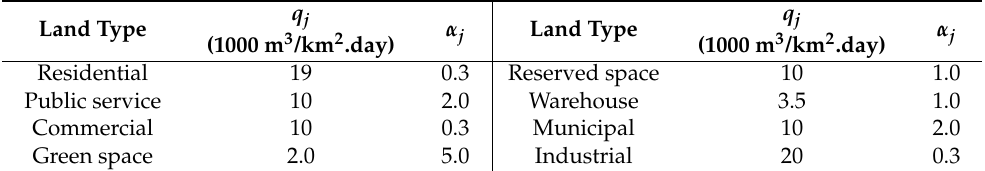
Table 5. Daily water demands and post-earthquake adjustment